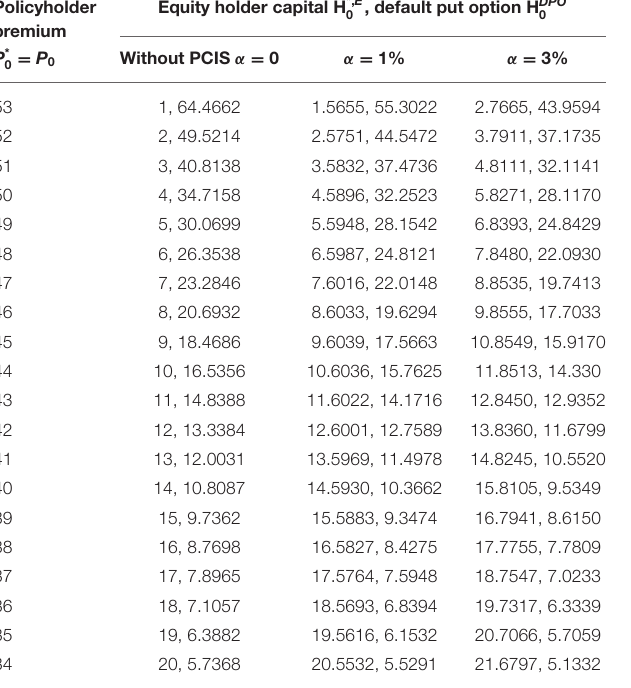
TABLE 5 | Adapted equity holder capital and default put option before and after introducing PCIS with insurer paying contribution. Policyholder premium